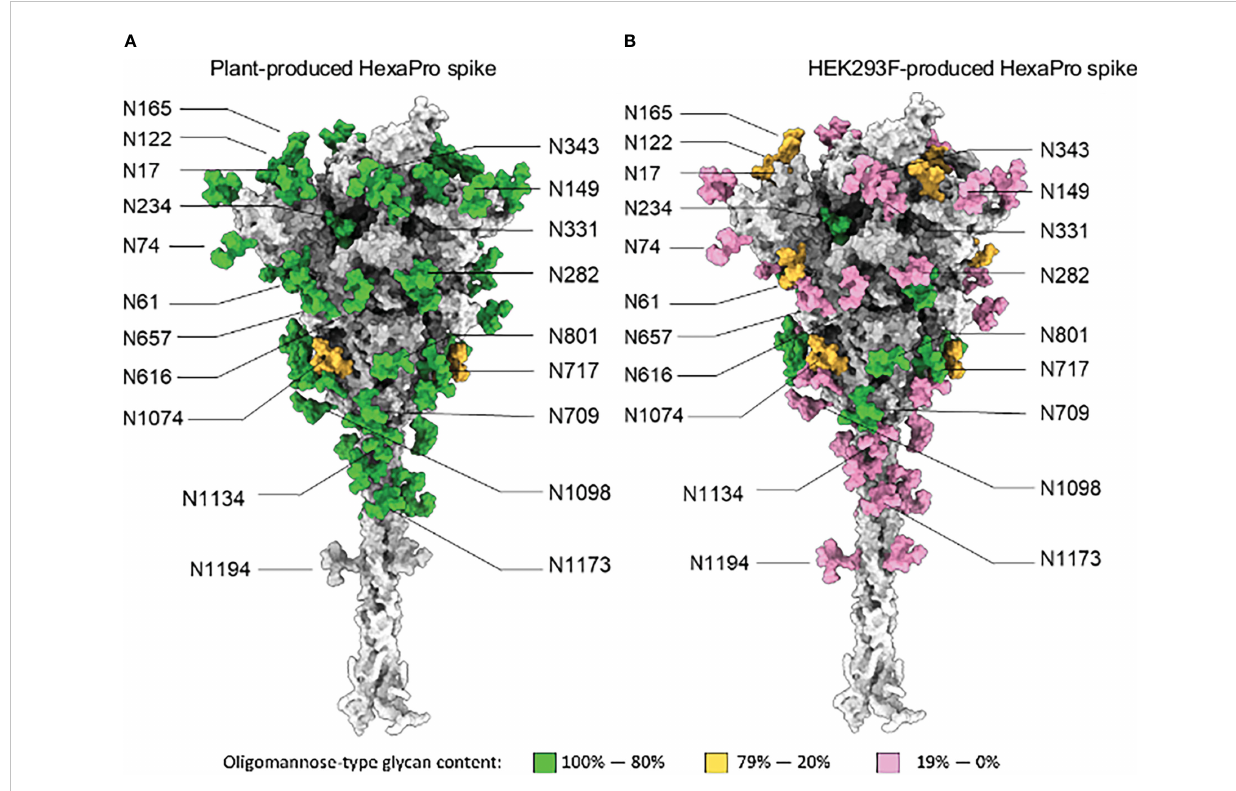
FIGURE 2 Site-speci fi c N-glycosylation of plant and HEK293F-produced spike. (A) Fully glycosylated model of the SARS-CoV-2 spike glycoprotein in a native- like prefusion conformation, generated previously by (Zuzic et al., 2022). The individual N-glycan sites were colored according to the site-speci fi c abundance of oligomannose-type glycans determined by LC-MS for spike protein produced using glycan enhanced N.benthamiana cells. (B) Model of the SARS-CoV-2 S protein produced in an identical manner to panel A except colored according to LC-MS analysis of spike protein produced by transient transfection of HEK293F